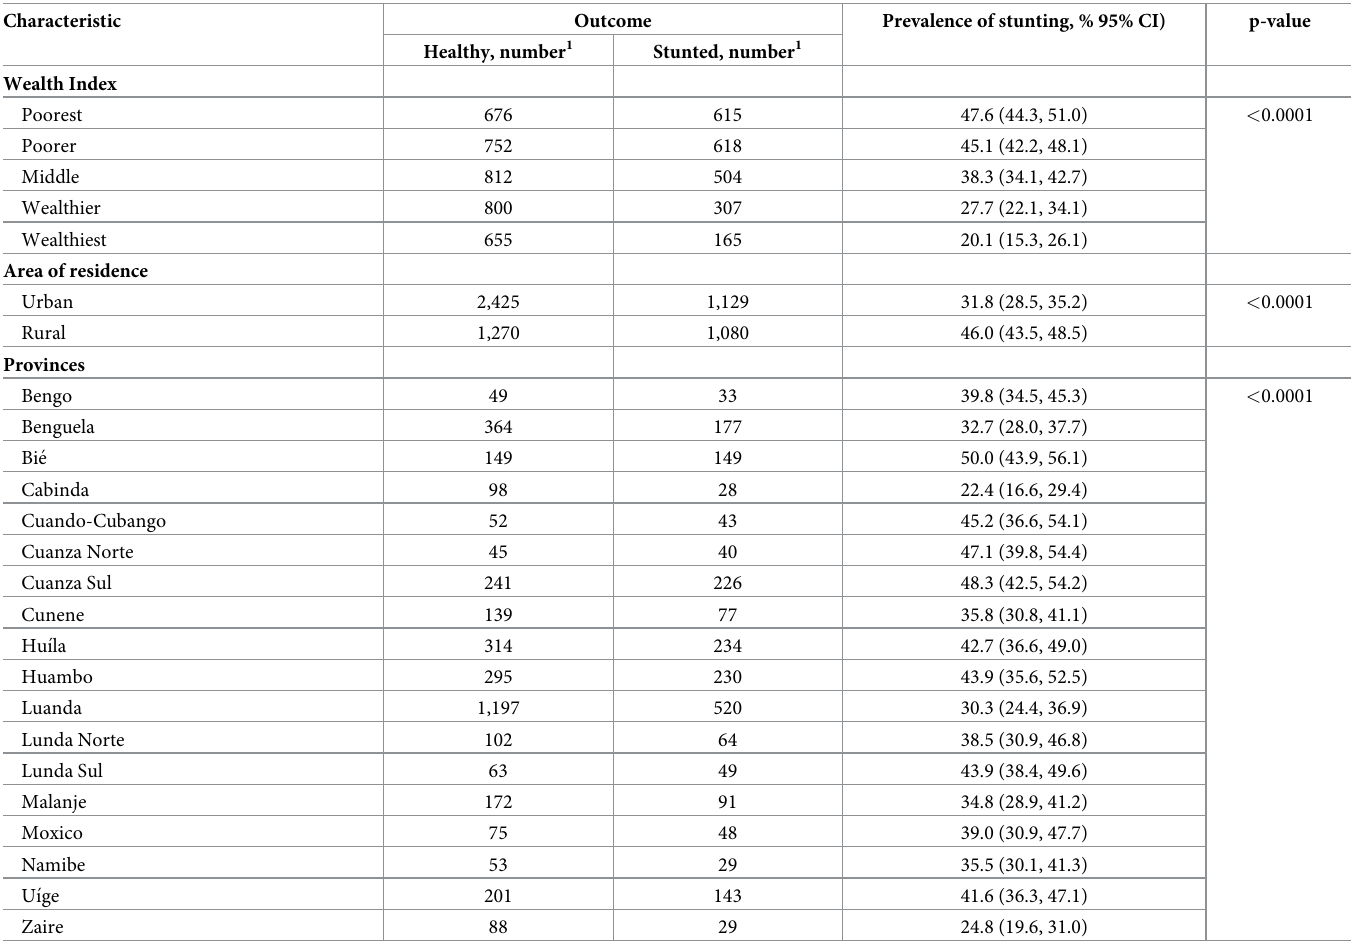
1 Values are weighted counts (n), and prevalence of stunting (95% confidence interval). P-values were obtained using the design-based F-score to account for the distinct weights of each observation resulting from the complex sampling procedure